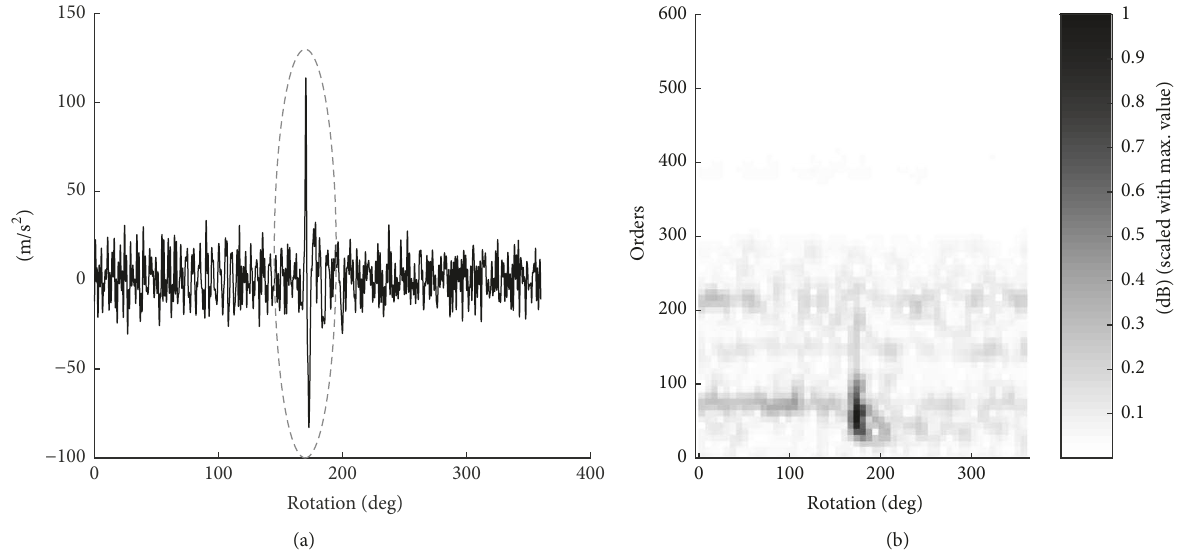
Figure 13: (a) Time Synchronous Average related to the intermediate shaft of Case 1 (the dashed circle highlights the impulsive signal component due to the damaged tooth engagement) and (b) the related spectrogram ( 300 samples of window length and 75 %